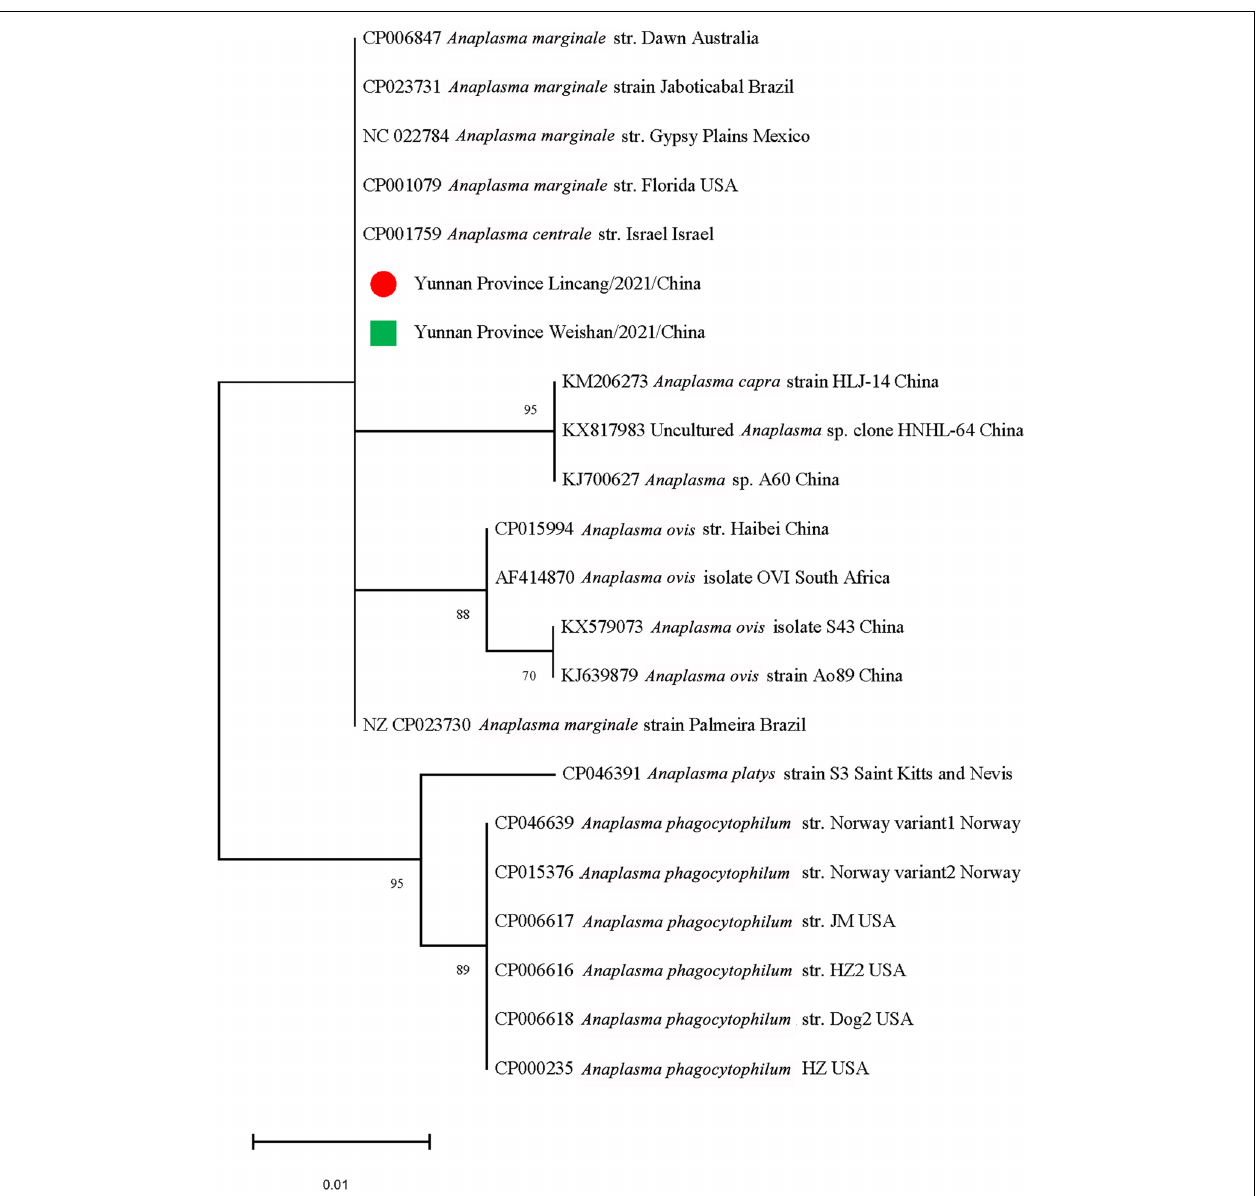
FIGURE 4 | Phylogenetic tree of Anaplasma marginale in ticks based on partial 16S rRNA gene sequence similarity. The sequences obtained in this study are indicated with a colored dot. Sequences were aligned using the MEGA X (Version 10.2.5) software package. Phylogenetic analysis was performed by the maximum likelihood method, and bootstrap values were estimated for 1,000